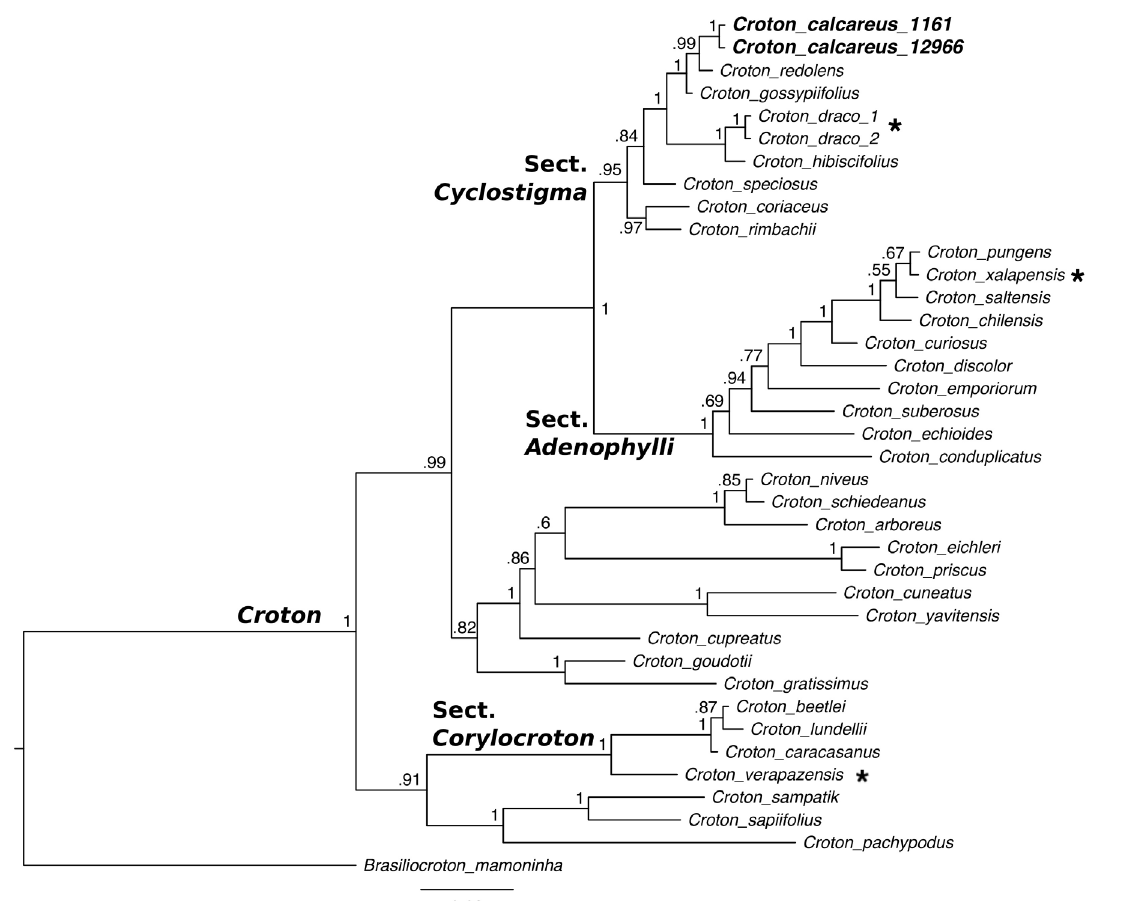
Fig. 1. Bayesian majority rule consensus phylogram of nuclear ITS data from a selection of Croton L. taxa including two accessions of Croton calcareus Riina & Mateo-Ram. sp. nov. Species marked with an asterisk correspond to those with which C. calcareus sp. nov. has been previously confused. The relevant clades are labelled on the left side. Numbers next to nodes indicate clade support (Bayesian posterior